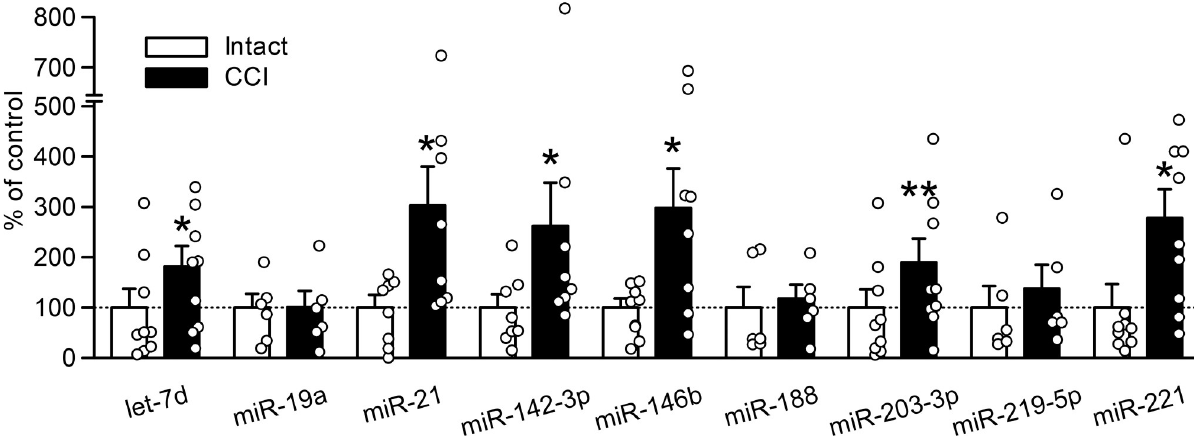
Fig 1. Extracellular miRNA levels in the culture medium of DRG cells after CCI. miRNA levels were examined in the EVs obtained from the culture medium of L4–L6 DRG neuron cultures on day 7 after CCI ( n = 6–9). � P < 0.05 or �� P < 0.01, compared with DRG neuron cultures obtained from the intact side (Wilcoxon signed-rank